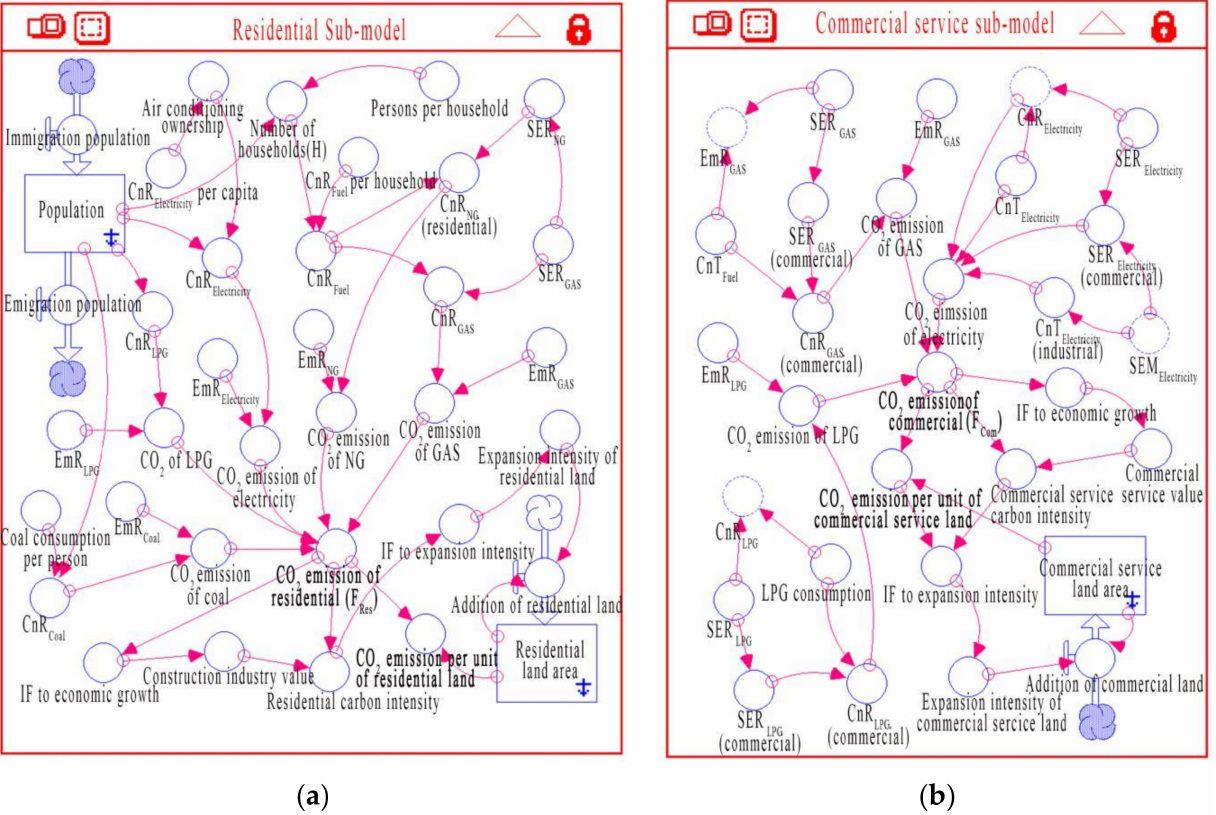
Figure 3. The CO 2 emissions stock and flow diagram. ( a ) Residential sub-model. ( b ) Commercial service